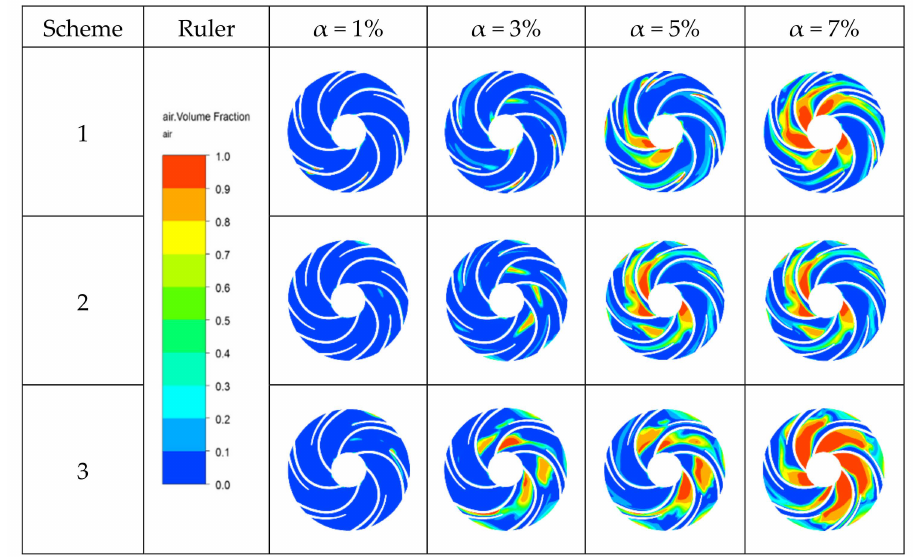
Figure 9. Gas distribution cloud map of the cross-section of the impeller flow field under di ff erent flow rates in water with various gas volume